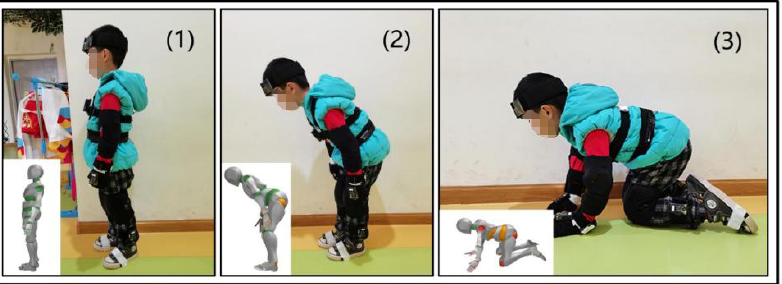
Figure 1. Evacuation postures. (1) upright walking; (2) stoop walking; (3) knee and hand crawling. 2.1. Participants